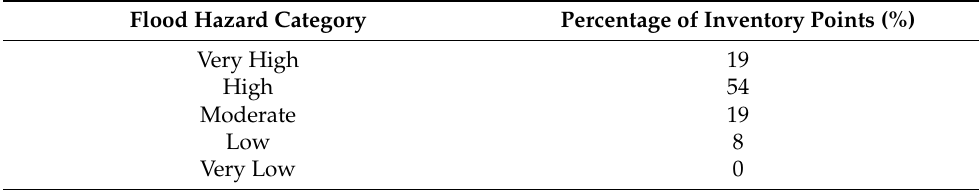
Table 6. Percentages of the flood inventory points within the flood hazard categories.